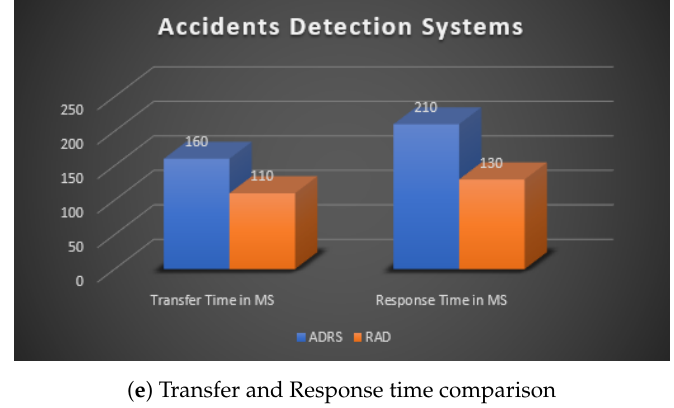
Figure 7. Simulation results.